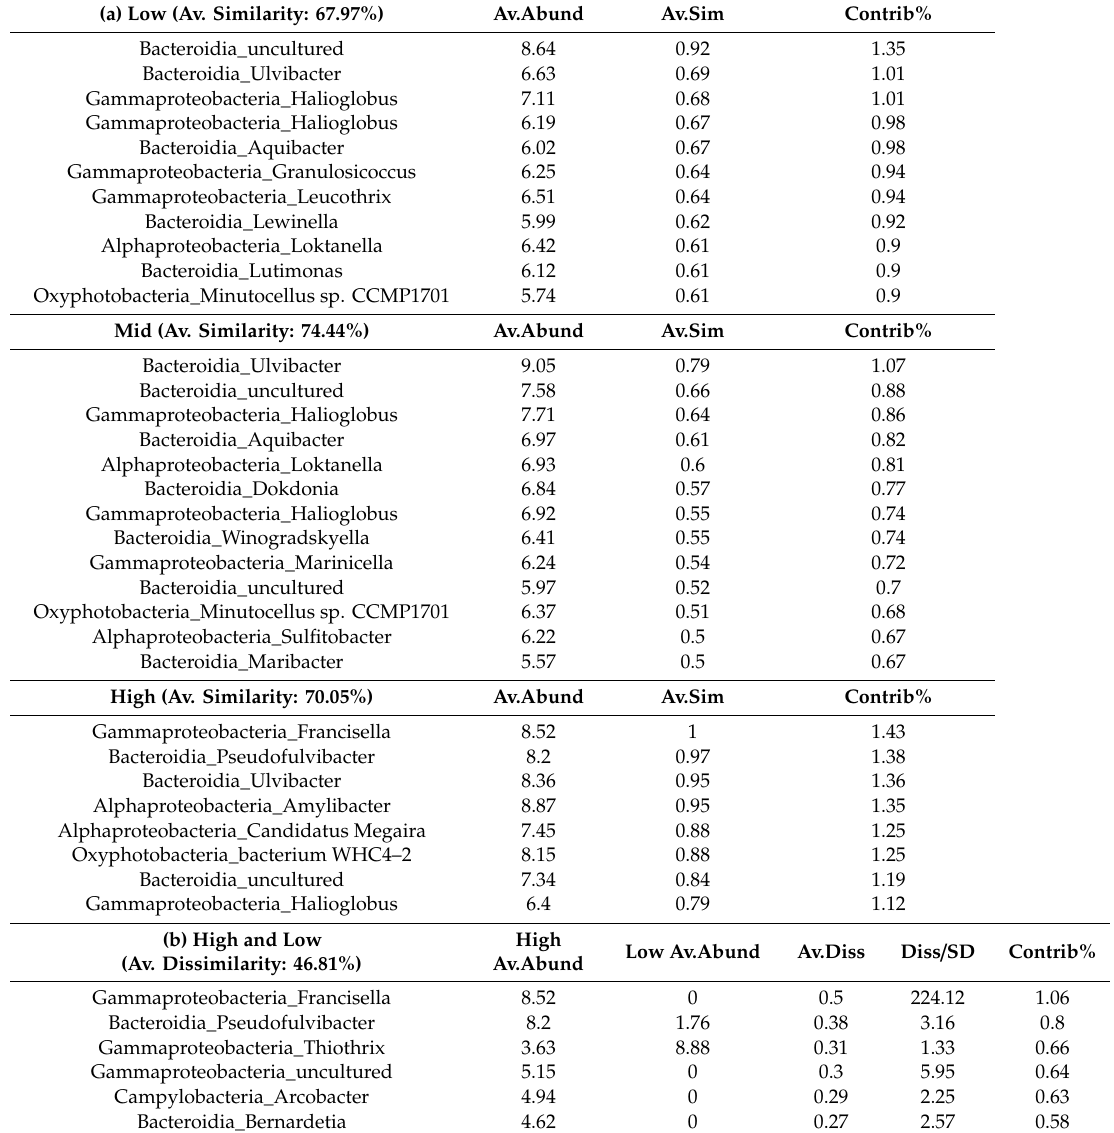
Table 3. SIMPER analysis on bacterial fourth root-transformed data showing the contribution of taxa to the average (Av.) Bray–Curtis similarity (a) and dissimilarity (b) between “Pressure” levels: Marine Protected Area (MPA), Low, Mid and High. Average (dis)similarities are indicated in brackets. (a) Low (Av. Similarity: